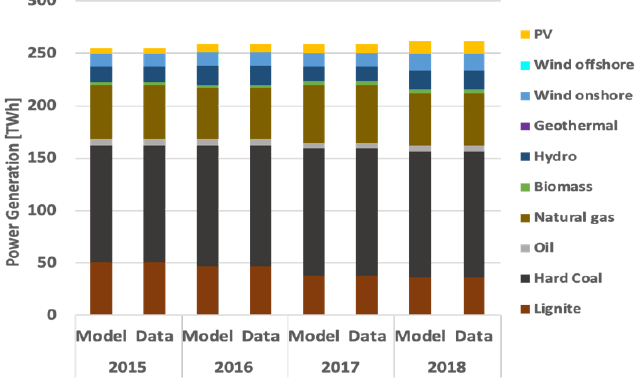
Figure A2. Calibrated model results versus real electricity generation mix over 2015–2018 (aggregated results for total Australia).